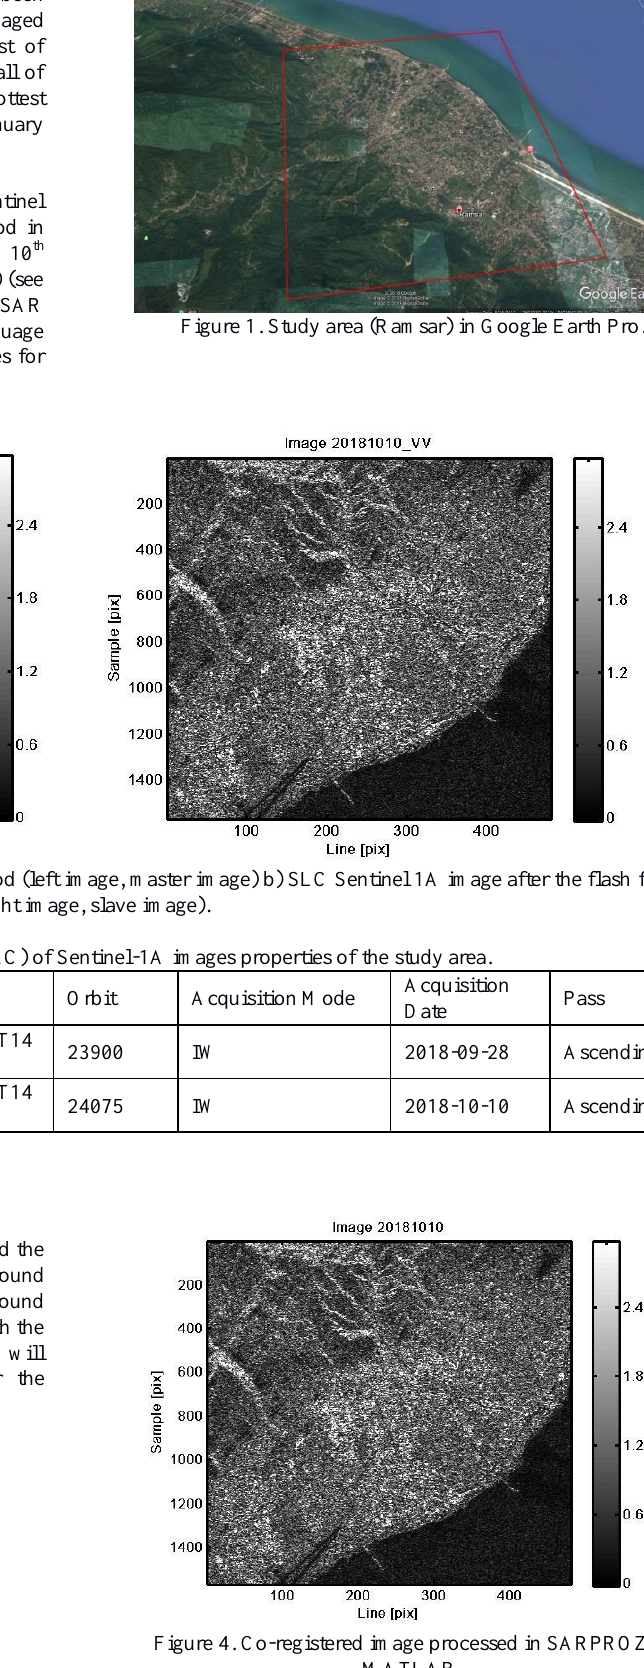
Figure 3. Workflow chart for flooded area detection caused by Ramsar flood.